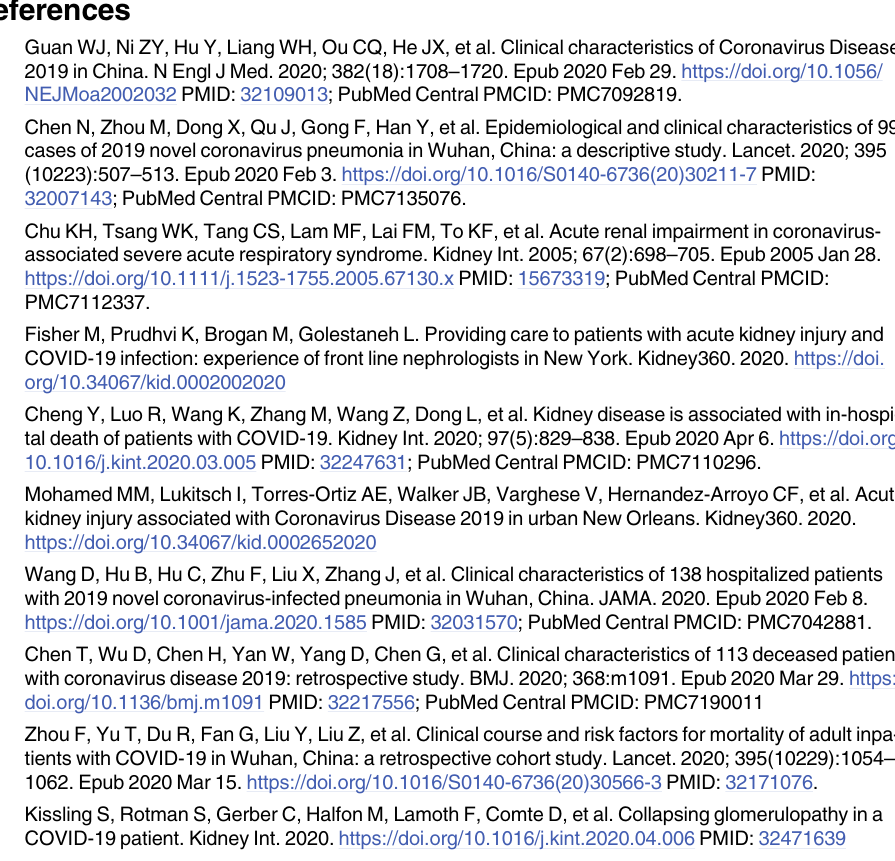
S4 Table. Predictors of mortality in AKI including Charlson comorbidity index.